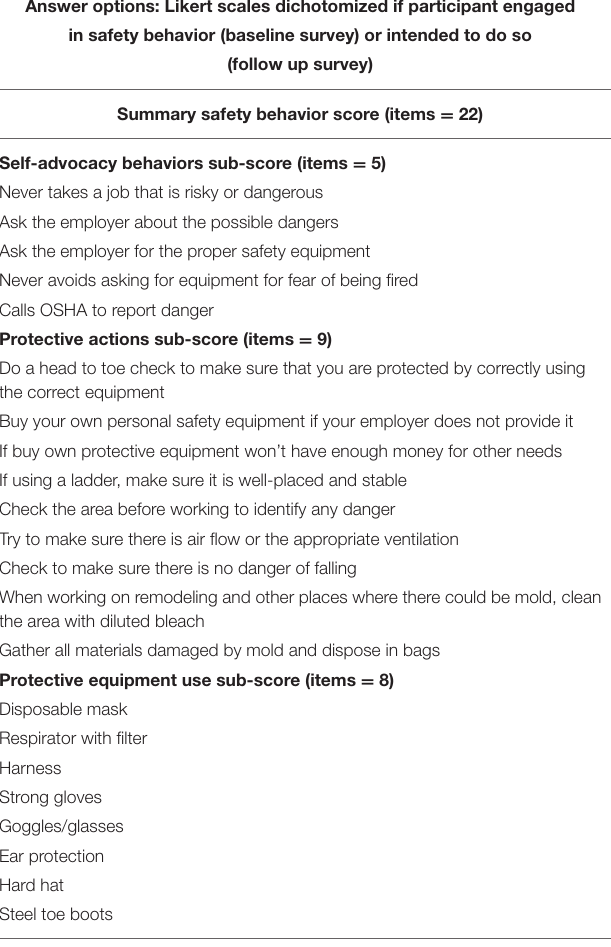
TABLE 2 | Preventive occupational safety behaviors associated with video intervention. Answer options: Likert scales dichotomized if participant engaged